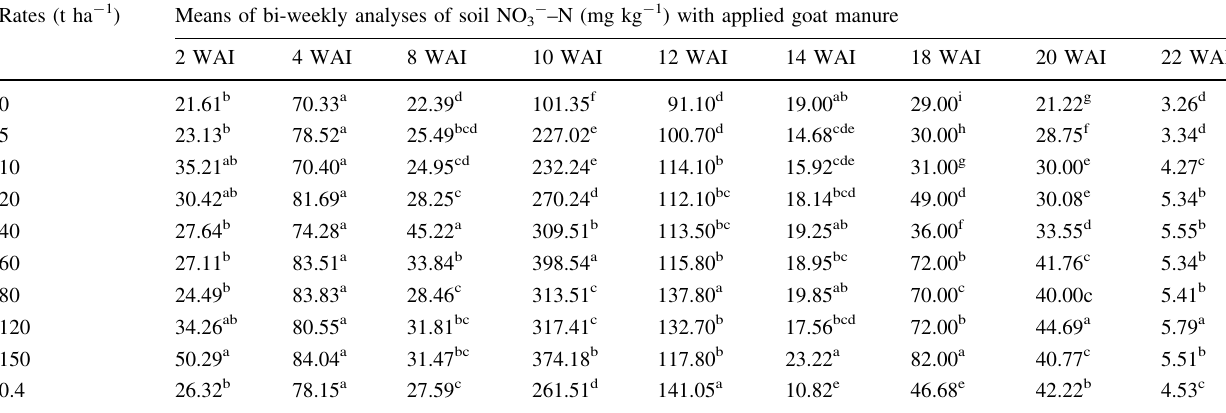
Table 9 Influence of goat manure rates and NPK fertilizer (t ha - 1 ) on mean soil NO 3 - –N (mg kg - 1 ) at 2 weeks intervals Rates (t ha - 1 )